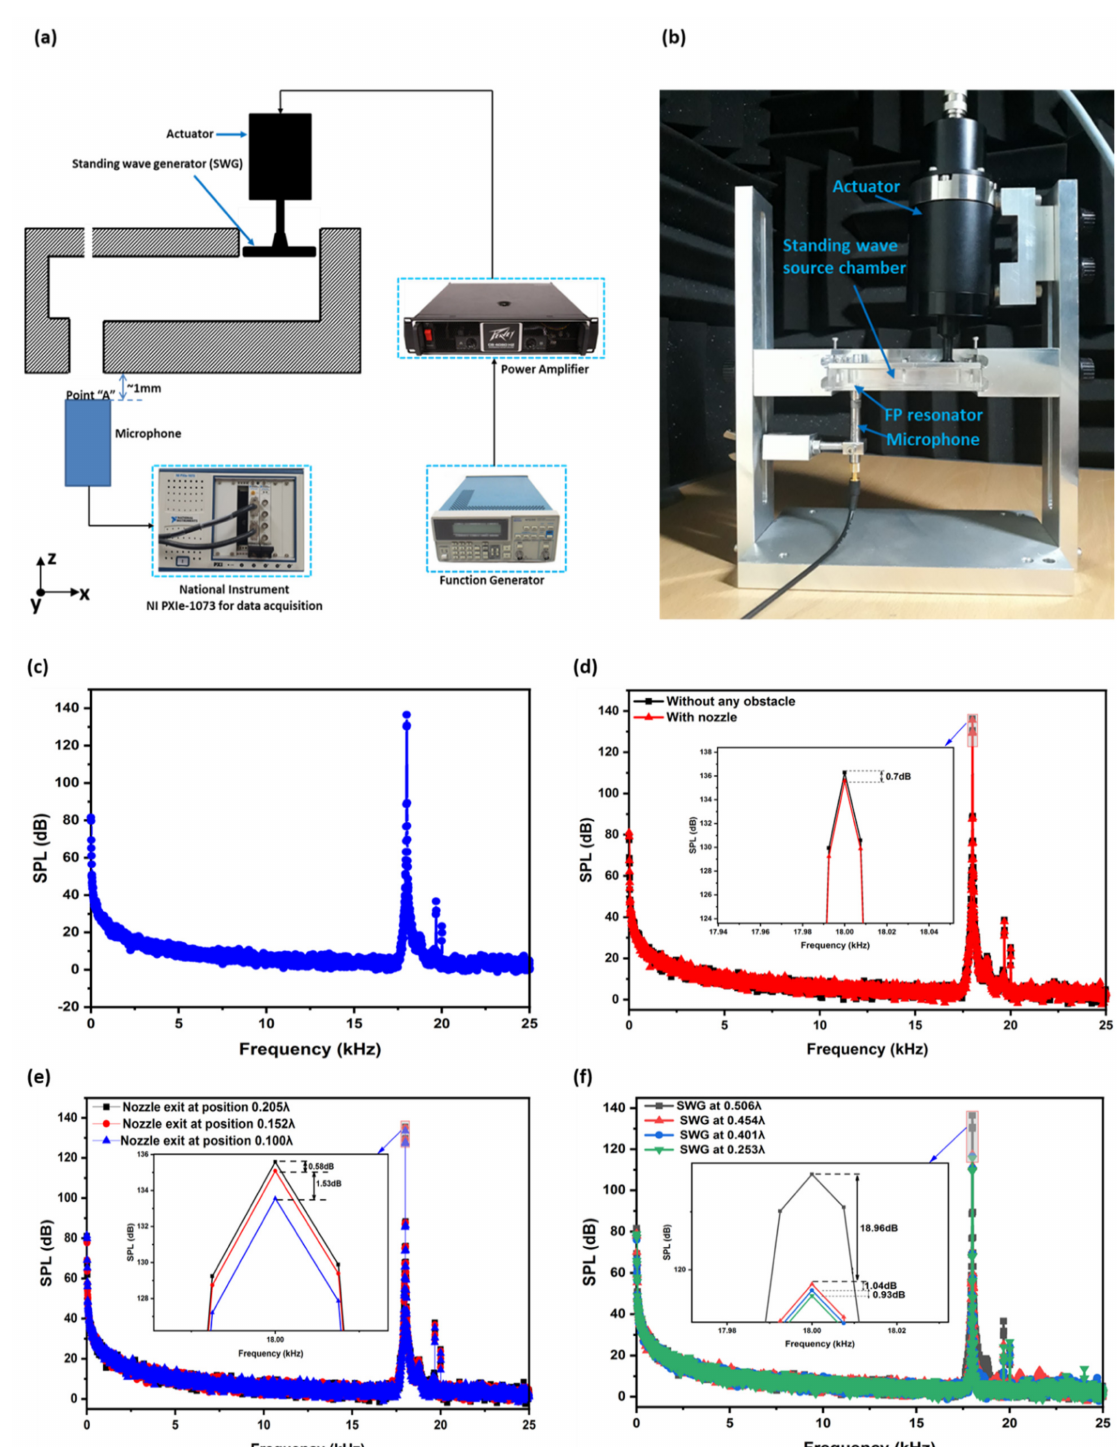
Figure 11. Experimental setup for SPL measurement. ( a ) Schematic representation, ( b ) setup of fabricated FP resonator-based printing device, actuator, and microphone for measuring SPL, ( c ) measured results of SPL at point A, ( d ) comparison of SPL at point A without any obstacle and with conical nozzle, ( e ) comparison of SPL at point A when the nozzle exit is placed at three different positions inside the FP resonator, and ( f ) comparison of SPL at point A when the SWGP was actuated at four different